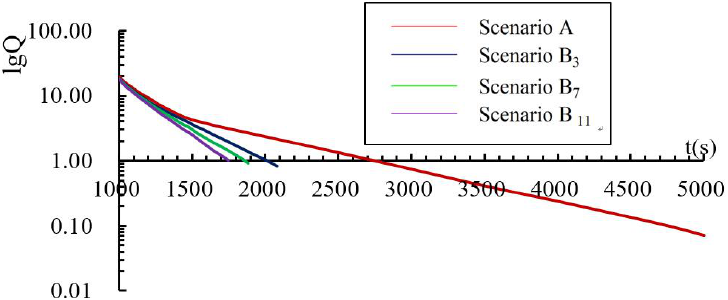
Figure 14. Recession curves of spring hydrographs with different pumping rate at W4. Figure 13. Recession curves of spring hydrographs with different pumping rate at W3. Figure 13. Recession curves of spring hydrographs with di ff erent pumping rate at W3. Figure 13. Recession curves of spring hydrographs with different pumping rate at W3.